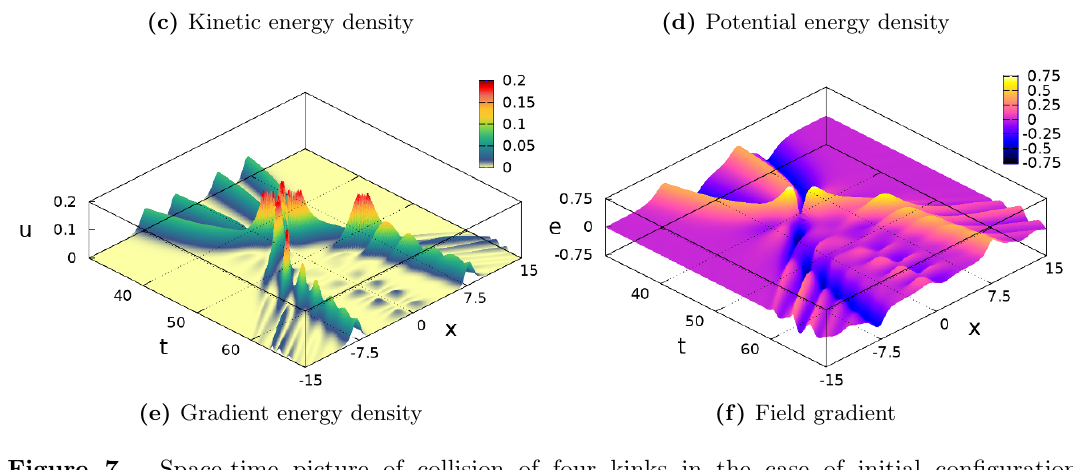
Figure 7. Space-time picture of collision of four kinks in the case of initial con(cid:12)guration (0 ; 1 ; 0 ; 1 ;